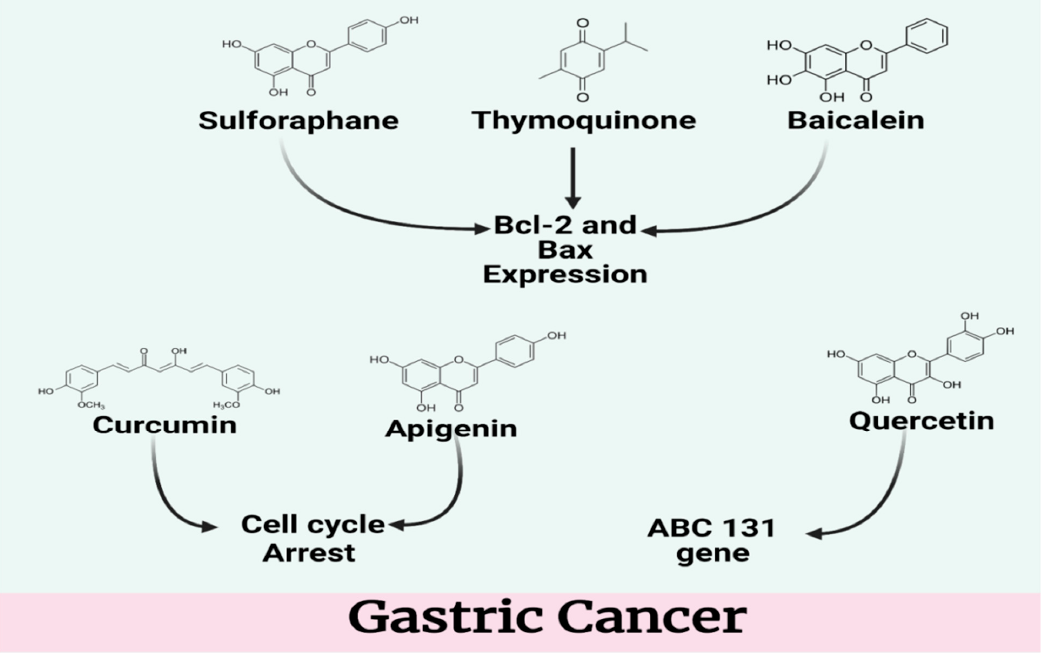
Figure 3. Illustration representing the probable sites blockaded by small molecules in gastric